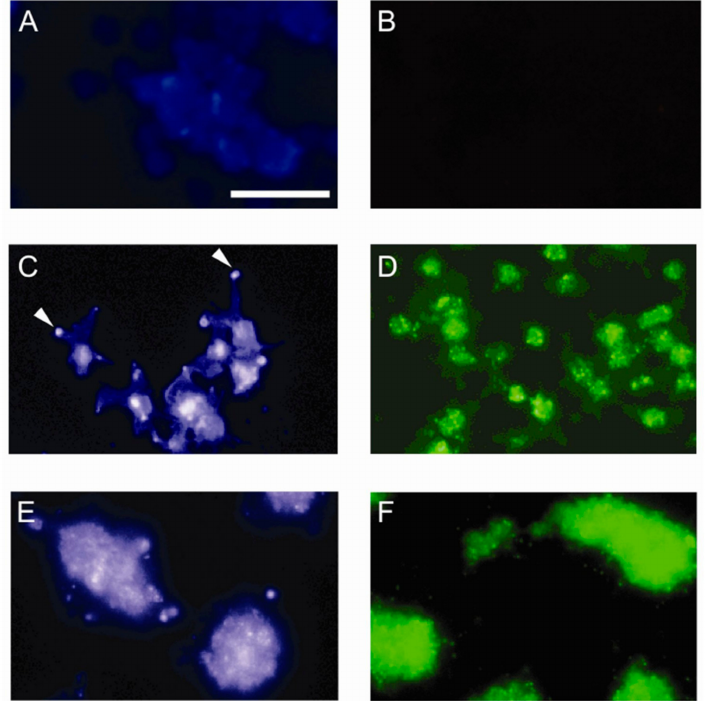
Figure 2. Sulfatide localization. Exposure of cholesterol (panels A , C , E ) and sulfatides (panels B , D , F ) in human platelets was determined by immunofluorescent labeling using filipin III for cholesterol detection and antibody SulphI for sulfatide detection. The cellular localization in resting human platelets (panels A and B ) was compared with platelets adhered to immobilized fibrinogen (panels C and D ) and collagen (panels E and F ) under flow at a shear rate of 300 s − 1 and 800 s − 1 , respectively. Arrowheads indicate redistribution of cholesterol in filopodia. (scale bar = 10 µ